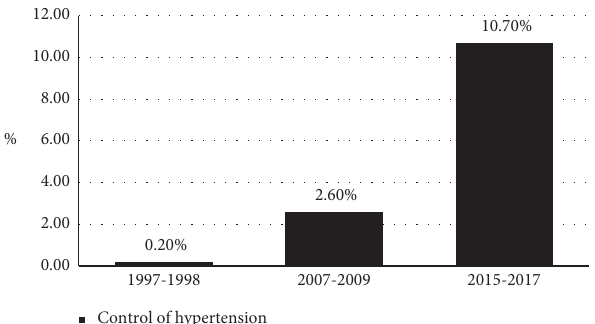
Figure 1: Changes in control of hypertension over